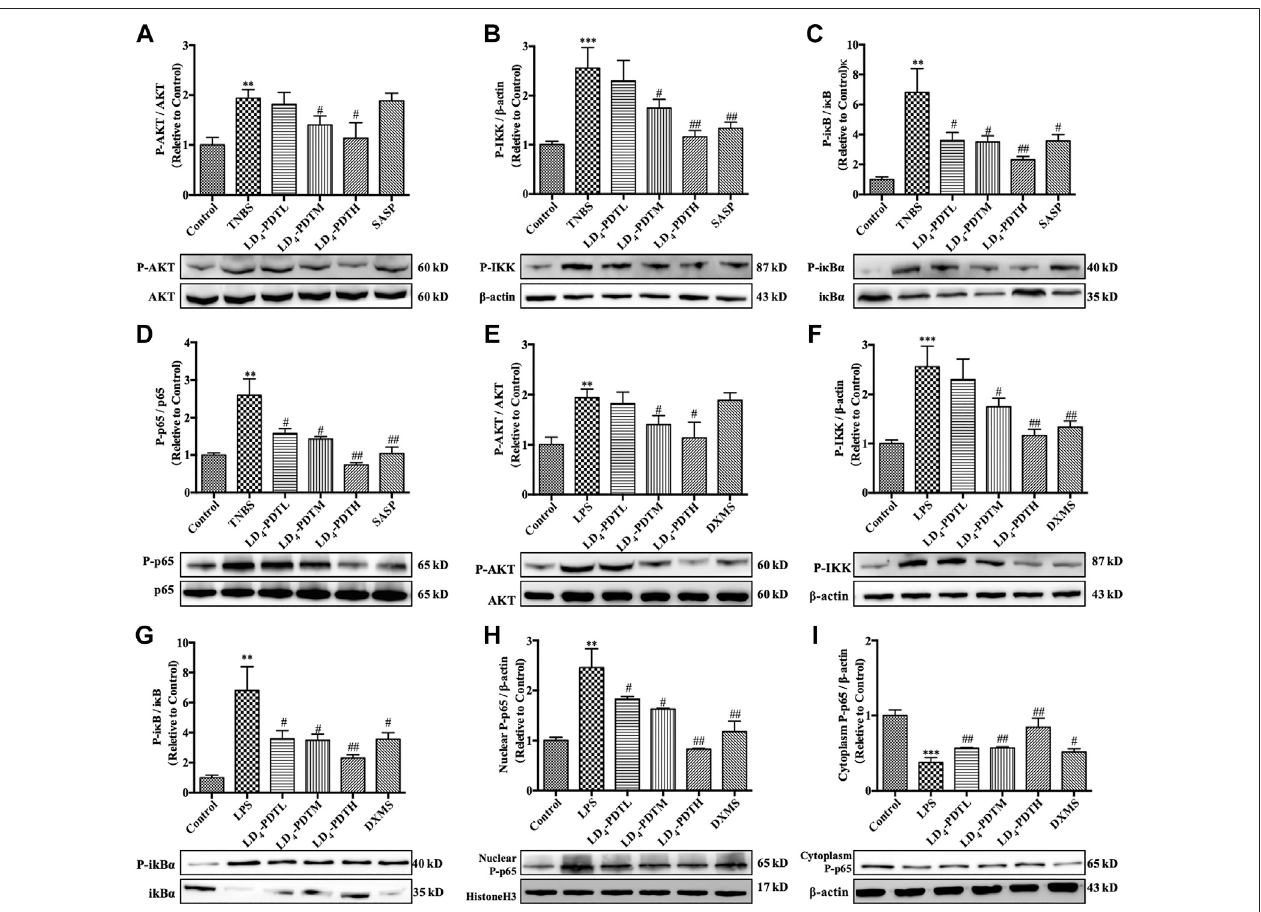
FIGURE6| LD 4 -PDT inhibited the expression of AOC 1 / AKT / IKK / NF- κ B . (A – D) Proteinexpression of (A) p-AKT , (B) p-IKK, (C) p-I κ B and (D) p-p65 incolon tissue were determined by western blot. (E – I) Protein expression of (E) p-AKT , (F) p-IKK , (G) p-I κ B , (H) p-p65 (in nuclear), and (I) p-p65 (in cytoplasm) in HCoEpiC cells were determinedbywesternblot** p < 0.01 ,*** p < 0.001 vscontrolgroup; # p < 0.05 , ## p < 0.01 , ### p < 0.001 vsTNBSmodelorLPSmodelgroup.Dataarerepresentativeof three independent experiments, expressed as mean ±